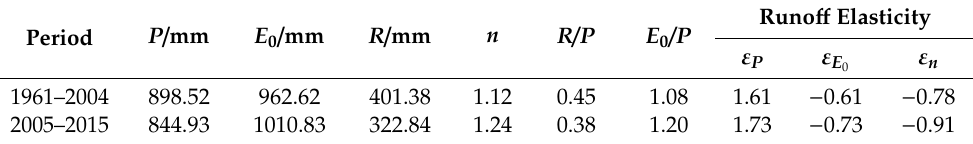
Table 3. Hydrological and climatic characteristics of LRB.